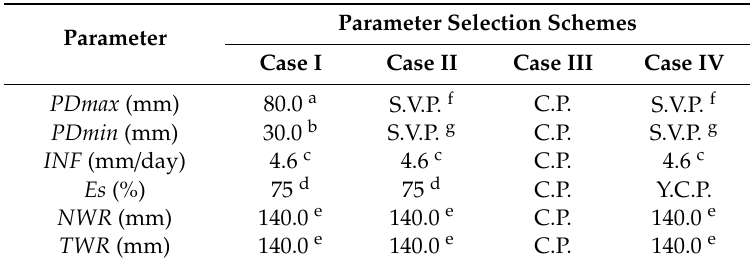
Table 2. The overview of the parameter selection schemes compared in this